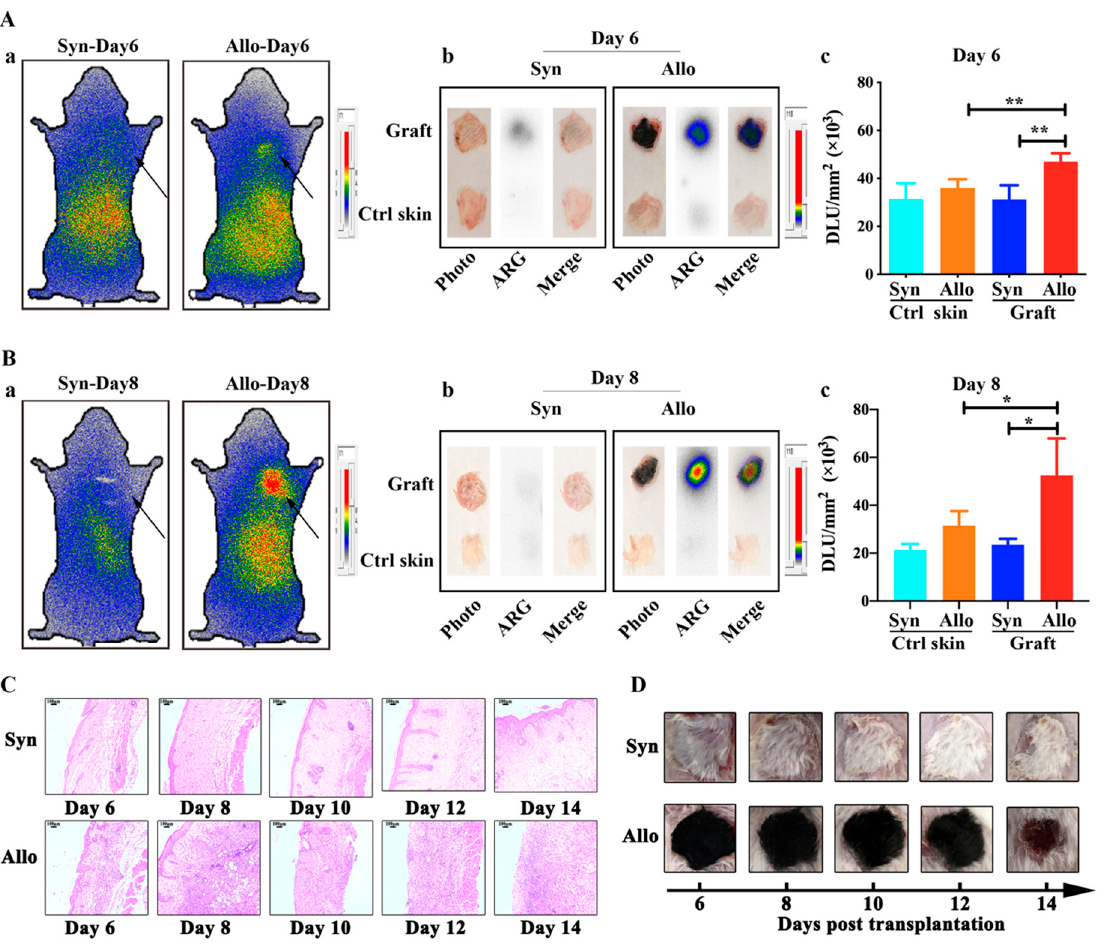
Figure 5. Whole-body phosphor-autoradiography imaging on day 6 and 8 post transplantation. The targeting ability of 125 I-anti-IL-27R α mAb in the early stage of allorejection. ( A , B ). On day 6 ( A ) and day 8 ( B ), the mice were injected with 125 I-anti-IL-27R α mAb: ( a ) Whole-body phosphor-autoradiography imaging of syngeneic and allogeneic grafted mouse. ( b ) Ex vivo phosphor-autoradiography imaging of allogeneic graft and opposite normal skin (Ctrl skin). ( c ) Semi-quantitative assay of radioactivity in allogeneic graft and Ctrl skin represented as DLU / mm 2 . ( C ). The H & E staining of syngeneic and allogeneic grafts from day 6 to 14 post transplantation. ( D ). The appearance of the graft from day 6 to 14 post transplantation. * p < 0.05, ** p < 0.01 vs. control group .